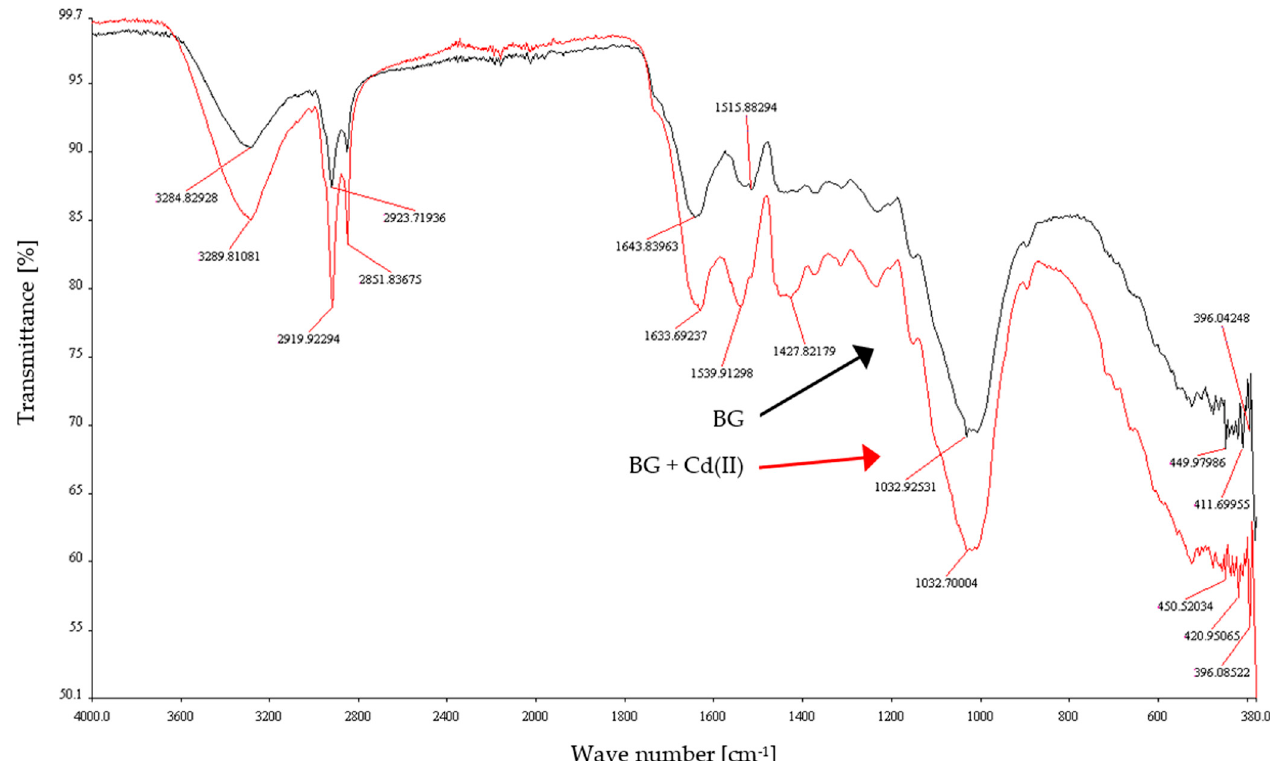
Figure 10. FT-IR spectrum of BG residues before and after Cd(II) ions adsorption. Table 2. FT-IR peaks of BG residues.